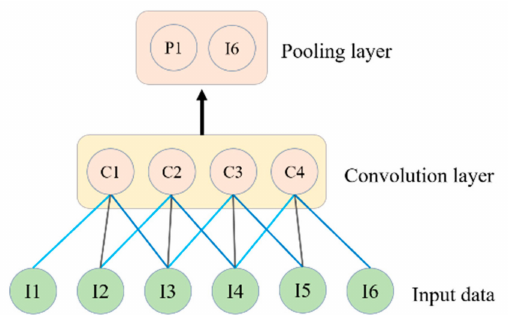
Figure 4. The operation of convolution layers and pooling layers over input